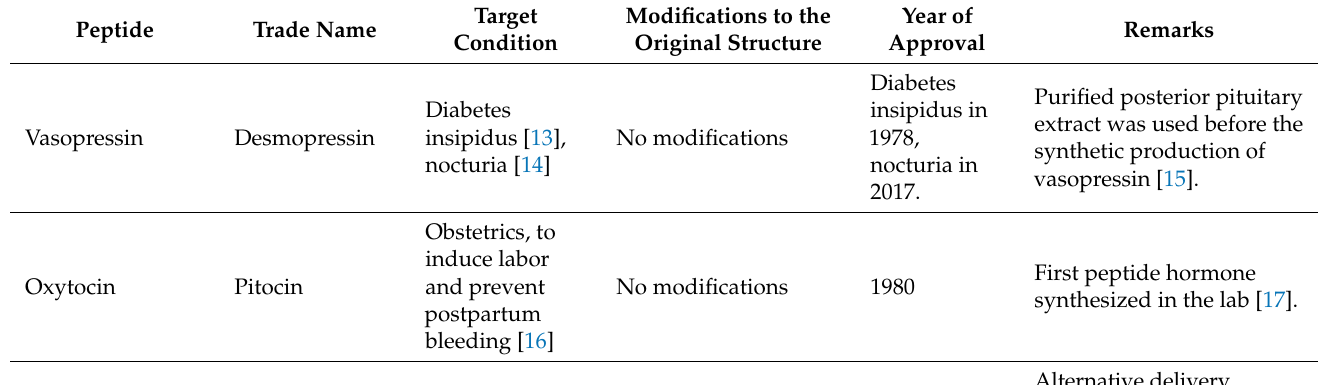
Table 1. Representative FDA-approved peptide-based